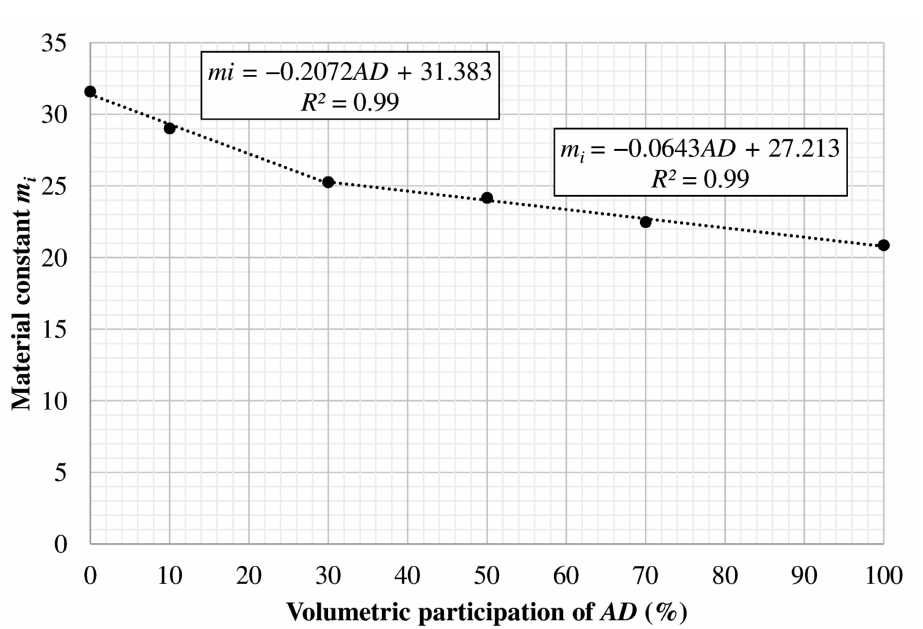
Figure 14. Values of the material constant m i for different participation of AD